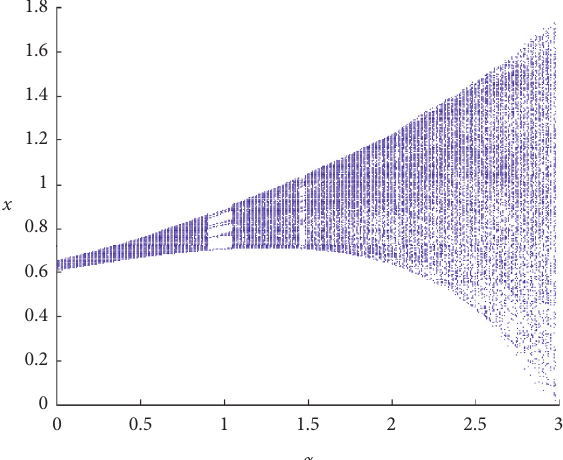
Figure 2: Flip bifurcation diagram versus parameters α when a � 1, b � 1.14, c � 2.93, d � 1.3, e � 0.21, f � 0.1, g � 0.35, h � 2, β � 0.2, c � 0.5.